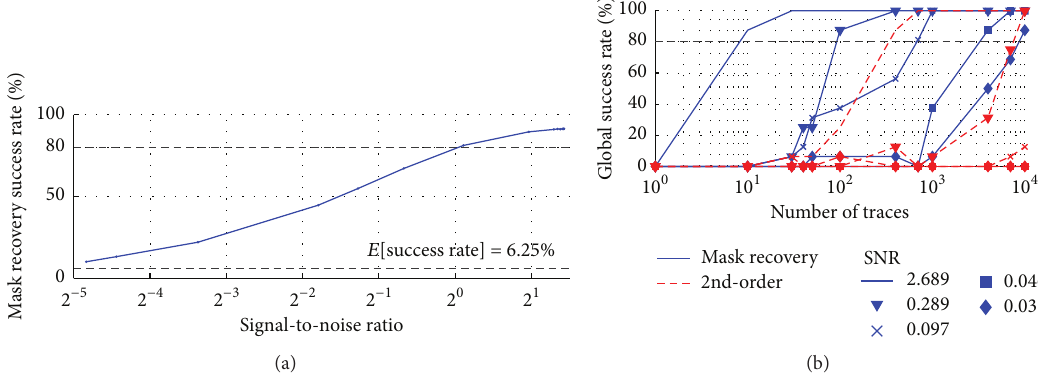
Figure 4: (a) Mask recovery success rate for 10,000 traces. (b) Global success rate (GSR) versus number of traces for different noise levels. The mask recovery attack outperforms the second-order attack by at least two orders of magnitude at every SNR.